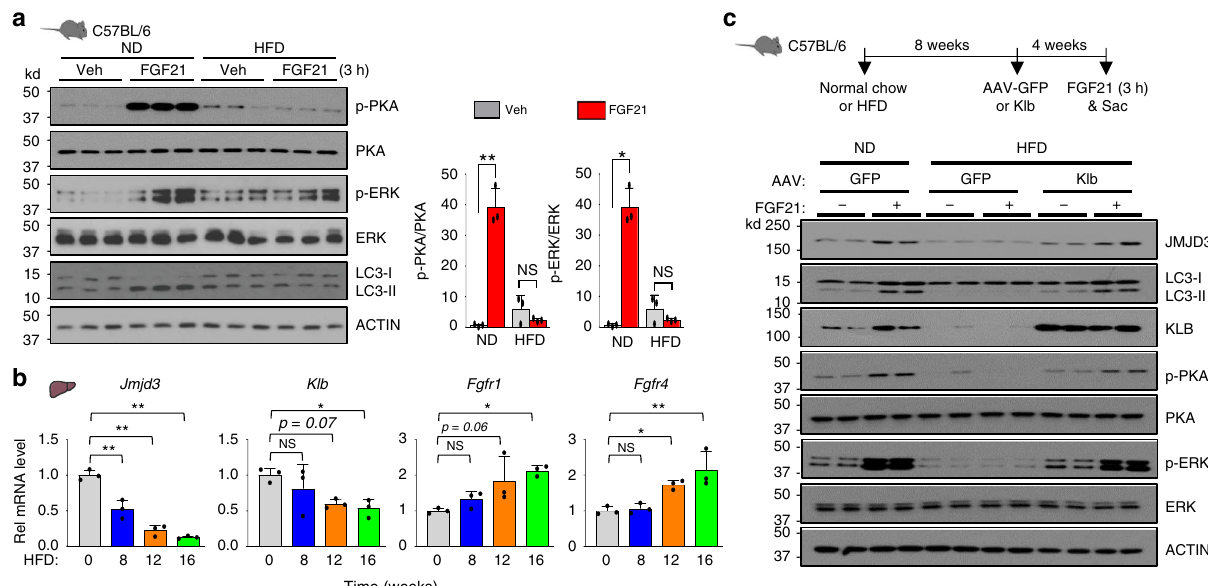
Fig. 8 Expression of KLB in obese mice restores FGF21 signaling and autophagy. a Mice that had been fed a ND or HFD for 12 weeks were treated i.v. for 3 h with 0.1 mg/kg FGF21, and hepatic levels of the indicated proteins were detected by IB (left, n = 3 mice). The ratios of band intensities for the indicated proteins are shown (right) . b Mice were fed a HFD for the times indicated and mRNA levels of Klb, JMJD3, Fgfr1, and Fgfr4 were measured by q-RTPCR ( n = 3 mice). c Mice fed a HFD for 8 weeks were injected with AAV-TBG-KLB or AAV-TBG-GFP. Four weeks later, the mice were treated i.v. with vehicle or 0.1 mg/kg FGF21 for 3 h, and hepatic protein levels of the indicated proteins were detected by IB (n = 2 mice). Source data are provided as a Source Data fi le. a , b Values are presented as mean ± SD. Statistical signi fi cance was measured using the a two-way ANOVA with the Bonferroni or b one-way ANOVA with the Dunnett post-test * P < 0.05, ** P < 0.01, and NS, statistically not signi fi